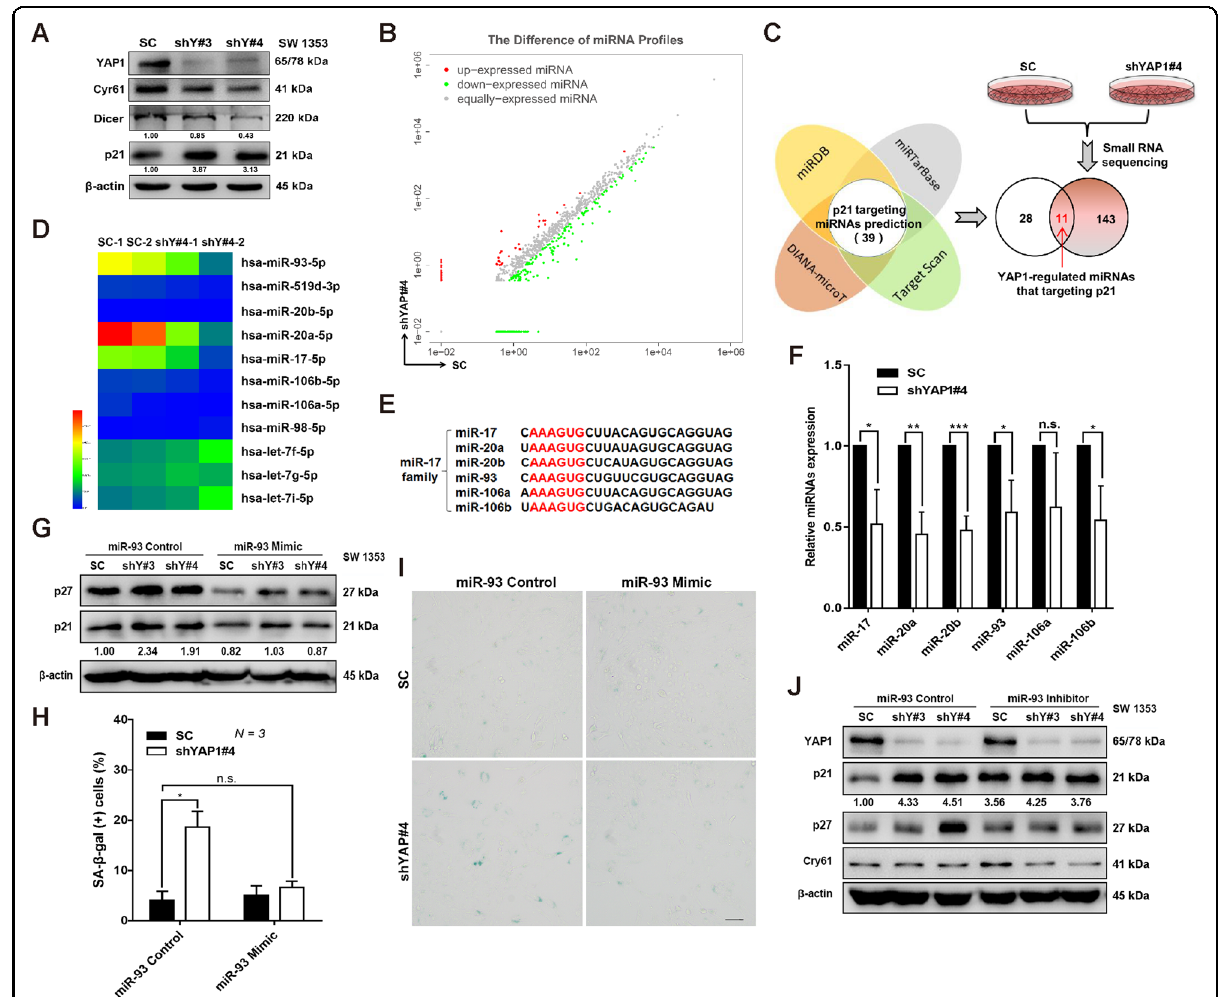
Fig. 5 Regulation of p21 by miR-93 is essential for YAP1 depletion-induced cellular senescence. A IB analysis of the indicated proteins in control shRNA or YAP1-depleted SW 1353 cells. Cry61 was used as a positive control for the inactivation of YAP1 signaling. B A total of 154 miRNAs were found to be up- or downregulated in YAP1-depleted SW 1353 cells by high-throughput small RNA sequencing. C Eleven p21-regulating miRNAs were identi fi ed in YAP1-depleted SW 1353 cells by overlapping the above sequencing data with the predicted p21-targeting miRNAs with the online tools miRDB, miRTarBase, TargetScan, and DIANA-microT. D Heat map of 11 miRNAs regulated by YAP1 in SW 1353 cells. E The consensus sequences targeting p21 in the miR-17 family members were aligned. F qRT-PCR was used to quantify the expression of miR-17, miR-20a, miR-20b, miR-93, miR-106a, and miR-106b in the indicated cells. G – I Control shRNA or YAP1-depleted SW 1353 cells were transfected with either miR-93 Control or miR-93 Mimic, and expression of p21 and p27 was analyzed by IB ( G ). The percentage of SA- β -gal-positive cells was quanti fi ed ( H ), and representative photos of the senescent cells are shown in ( I ), scale bars: 20 μ m. J Control shRNA or YAP1-depleted SW 1353 cells were transfected with either miR-93 Control or miR-93 Inhibitor, and expression of the indicated protein was detected by IB. Data are presented as the mean ± SD of at least three independent experiments in ( F , H ). Student ’ s t -test for ( F ). Two-way ANOVA followed by Tukey ’ s test for ( H ). n.s. nonsigni fi cant, ** P < 0.01, *** P < 0.001, **** P <